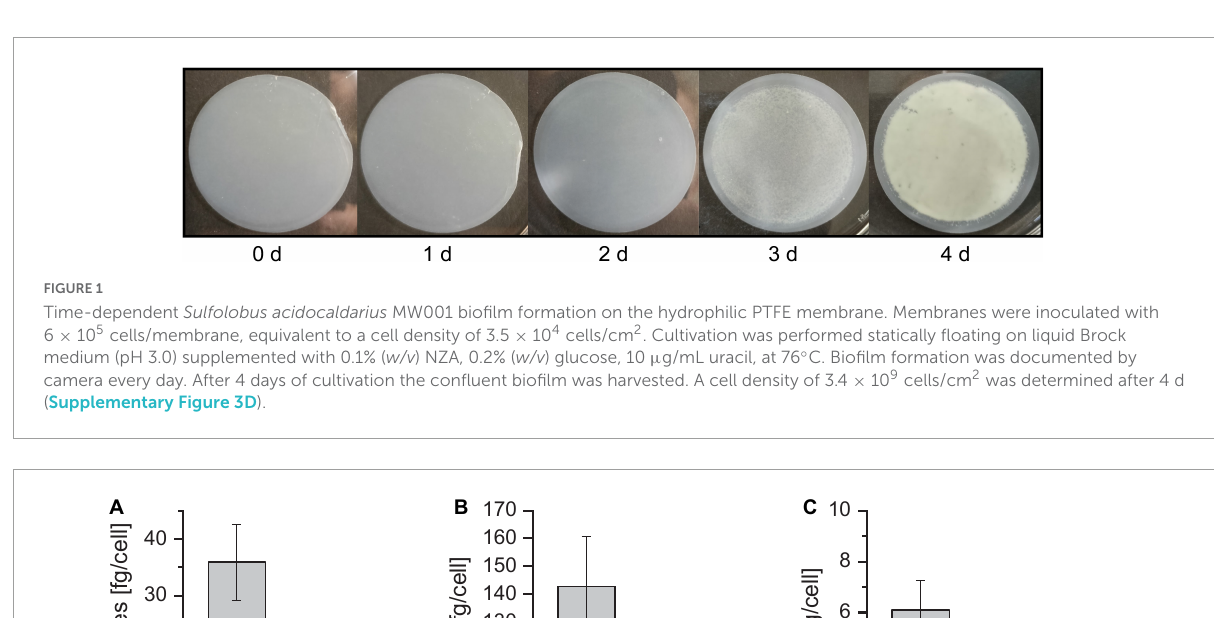
( Figure 2 ). The mass ratios of proteins:carbohydrates:eDNA were approx. 8:4:1 under the chosen growth conditions.